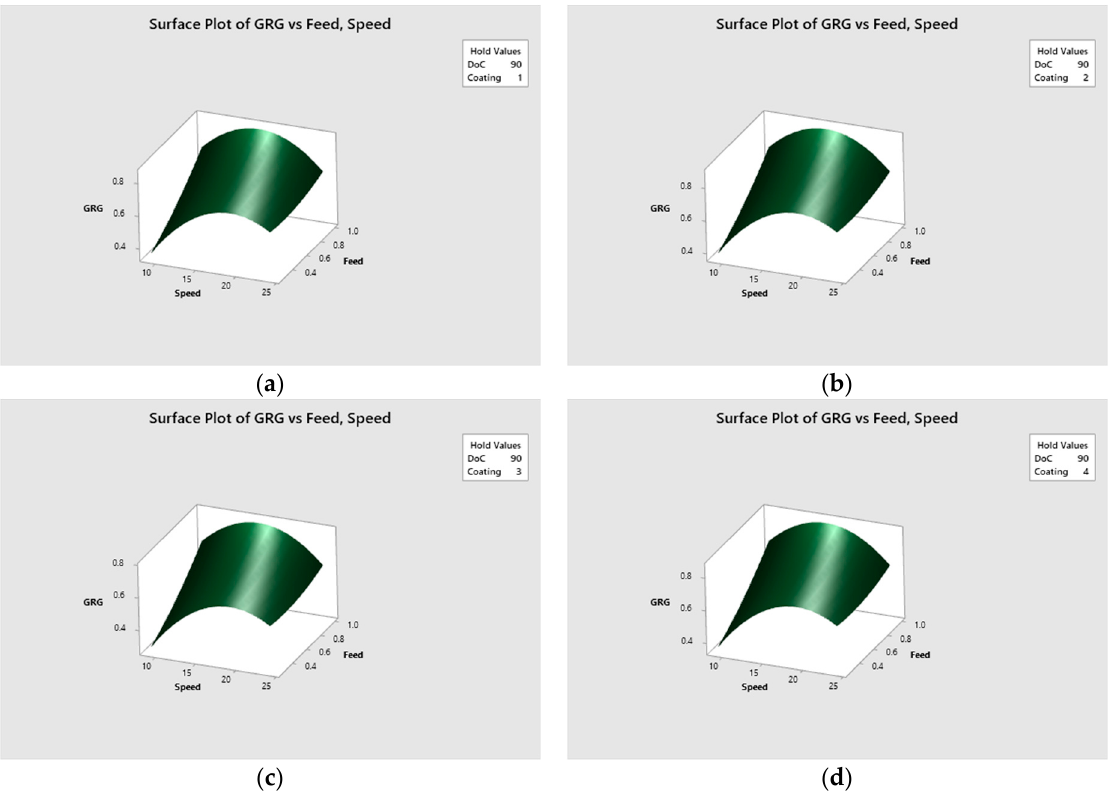
Figure 6. Surface plots of GRG vs tool coatings ( a ) nACo, ( b ) AlTiN, ( c ) TiSiN, ( d ) uncoated.